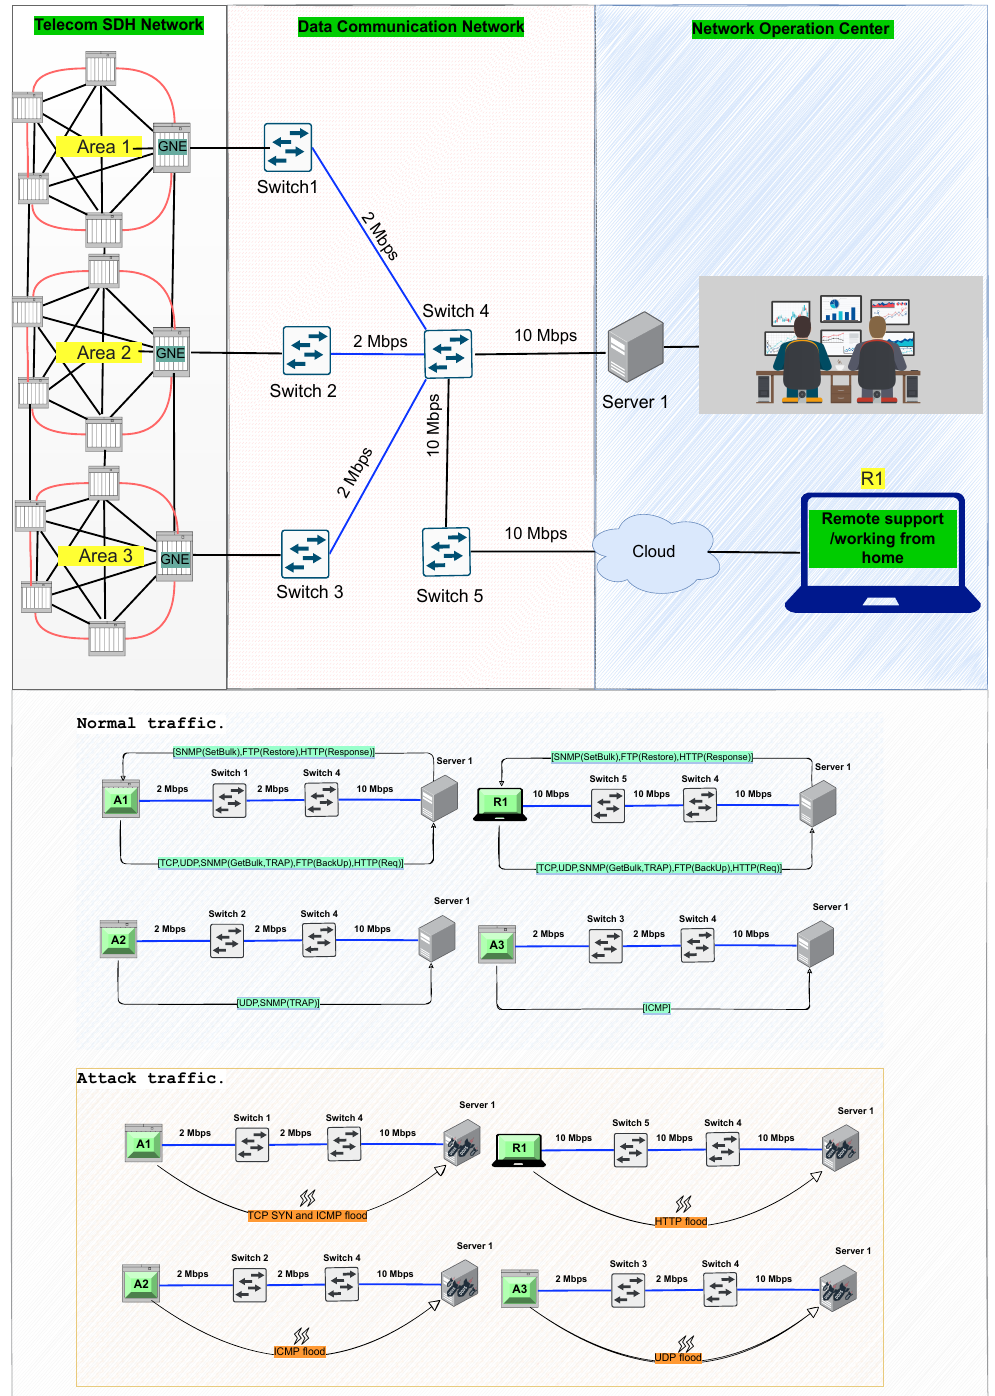
Figure 6. Suggested topology and normal/attack traffic